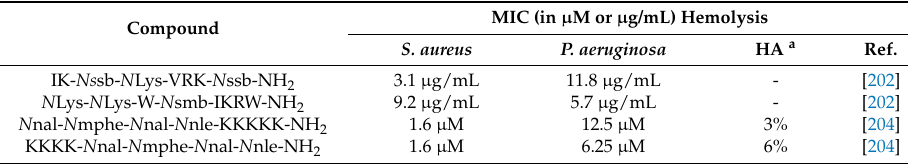
Table 5. Antimicrobial and hemolytic activity of representative peptide-peptoid